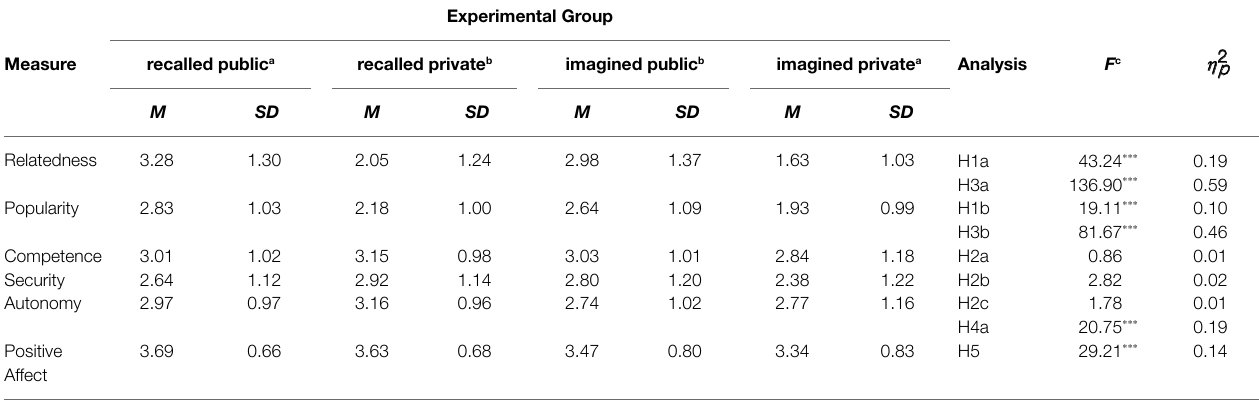
Experimental Group